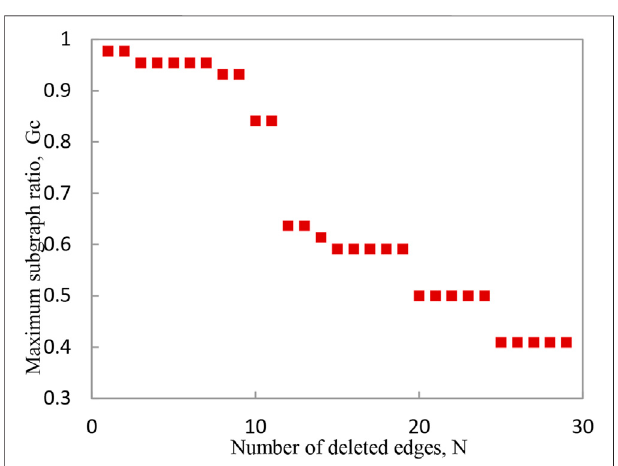
FIGURE 10 | The statistical diagram of each node ’ s local degree. TABLE 5 | The node ’ s position importance sorting table.